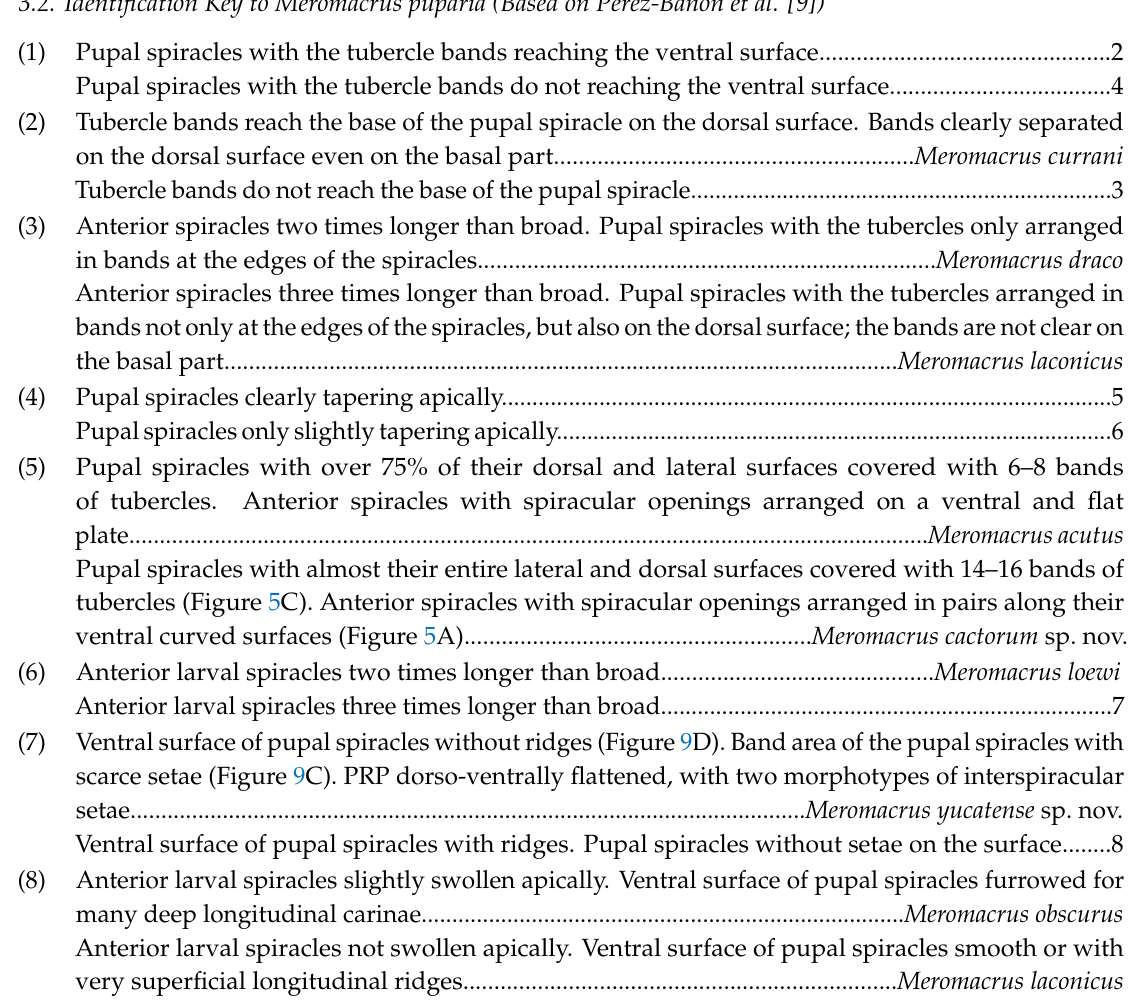
Anterior spiracles two times longer than broad. Pupal spiracles with the tubercles only arranged in bands at the edges of the spiracles.......................................................................... Meromacrus draco Anterior spiracles three times longer than broad. Pupal spiracles with the tubercles arranged in bands not only at the edges of the spiracles, but also on the dorsal surface; the bands are not clear